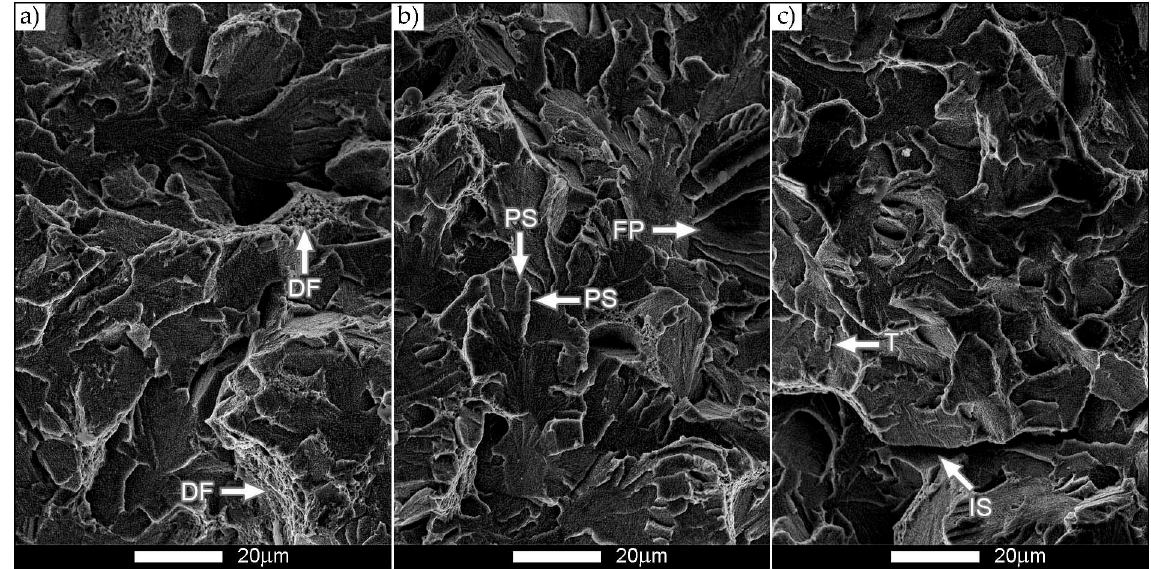
Figure 15. Images of the Hardox Extreme steel fracture surface in normalized state shown in Figure 10: longitudinal orientation (+20 °C). ( a ) The area marked with the A1 frame. ( b ) The area marked with the B1 frame. ( c ) The area marked with the C1 frame. DF—ductile fracture, PS—parallel steps, FP—fan pattern, T—tongues, IS—intergranular steps. SEM, non-etched state.